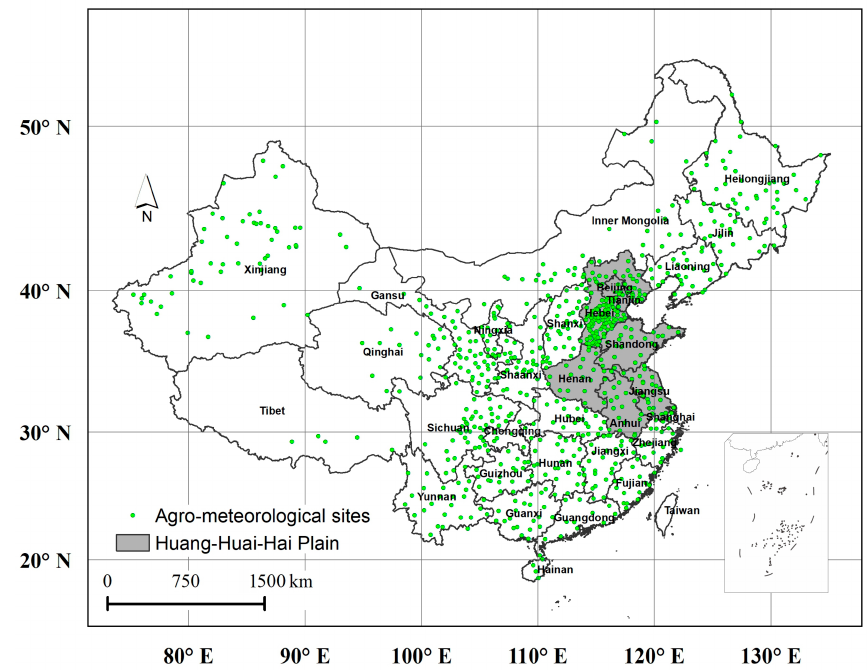
Figure 1. Spatial distribution of agro-meteorological sites in China.